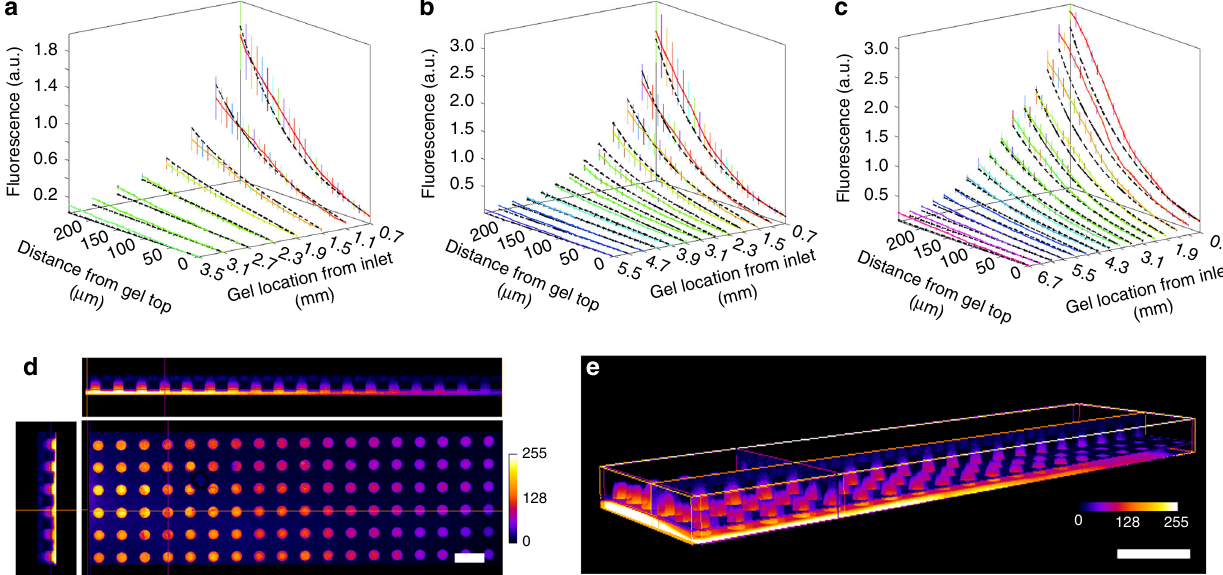
Fig. 2 Experimental and computational characterization of gradient generation. a – c Comparison of the experimental measurements (colored solid lines) and theoretical modeling (black dash lines) of the gradient pro fi les in the hydrogel cylinders at 7 h ( a ), 12 h ( b ), and 24 h ( c ) after addition of fl uorescent dextran, n = 3, error bars indicate standard error of the mean. d Fluorescent images of different cross-sectional planes showing the 3D distribution of FITC- dextran molecules in the hydrogel cylinders after 12 h diffusion. Scale bar, 500 µ m. e 3D reconstruction of the confocal scans showing the overall gradient generation in the HT-ChemoChip. Scale bar, 1 mm. Source data are presented as a Source Data fi le